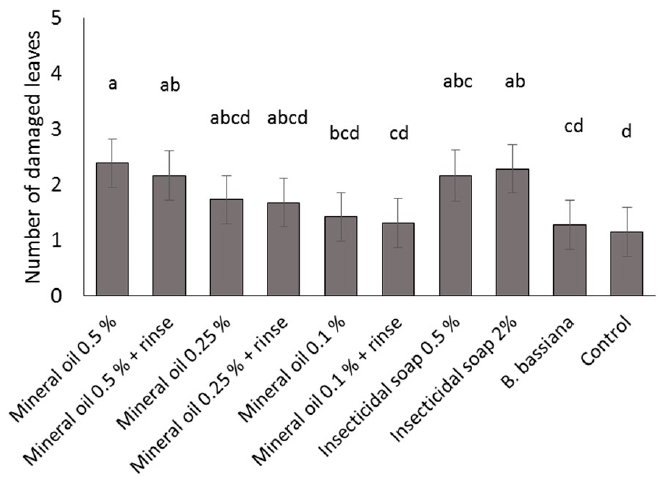
Figure 1. Phytotoxicity (mean ± SE of damaged leaves per cutting) of reduced risk and biopesticide products applied as cutting dips to greenhouse poinsettia. Different letters indicate significant differences among products ( α = 0.05).